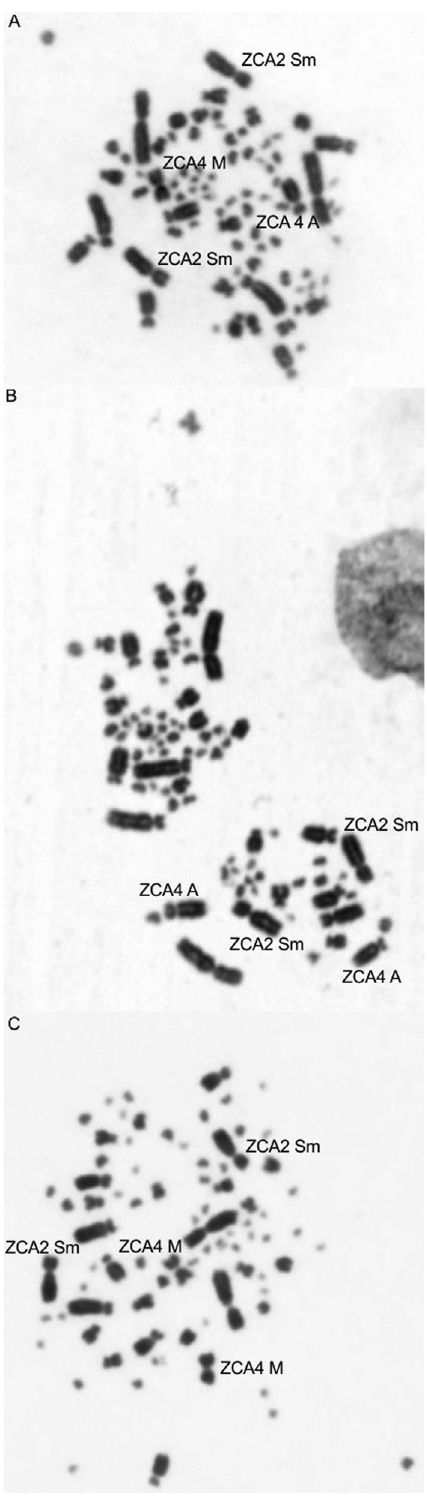
Figure 1 - Metaphases of three individuals of rufous-collared sparrow showing the occurrence of a polymorphism in pair 4, which has metacen- tric or acrocentric morphology. (A) Male: metacentric-acrocentric (B) Male: acrocentric-acrocentric, (C) Female: metacentric-metacentric. The arrows indicate the chromosomes of pair 2 (the species shows poly- morphisms in this pair, according to the literature, but in the sampled indi- viduals, we observed only the submetacentric morphology) and pair